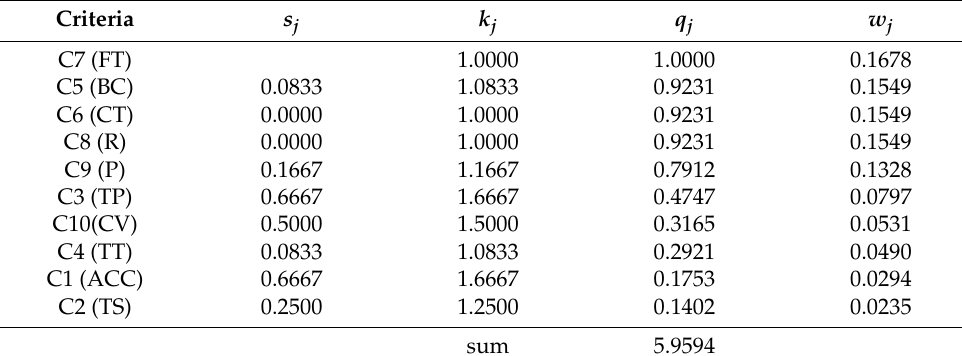
Table 4. SWARA-based criteria weight